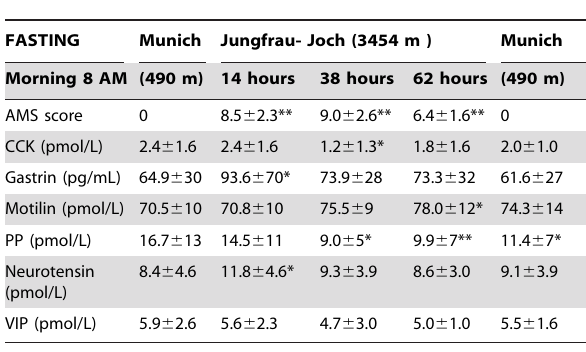
Table 1. Influence of rapid exposure of 11 subjects to high altitude on fasting plasma concentrations of gastroentero- pancreatic peptides and on acute mountain sickness (AMS) score at 8 a.m.